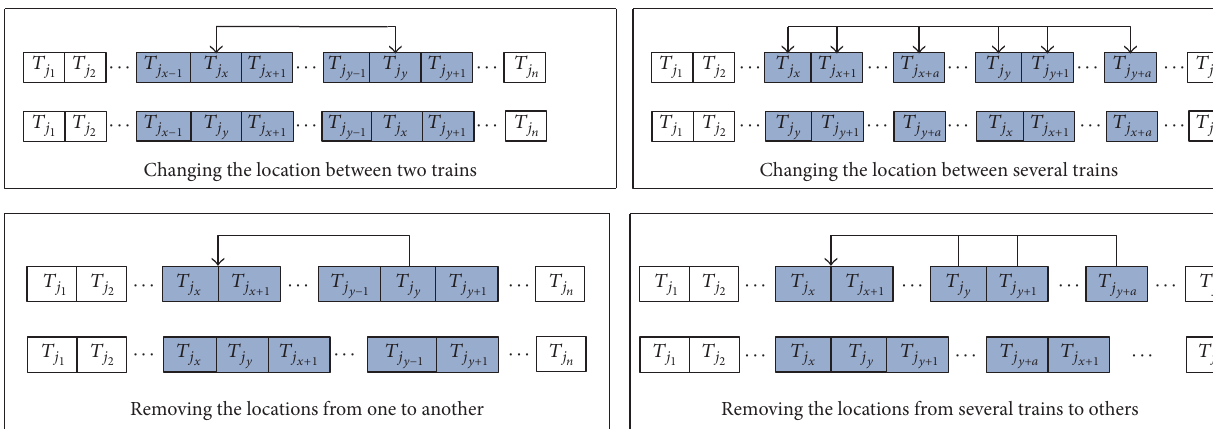
Figure 6: The rules of neighborhood